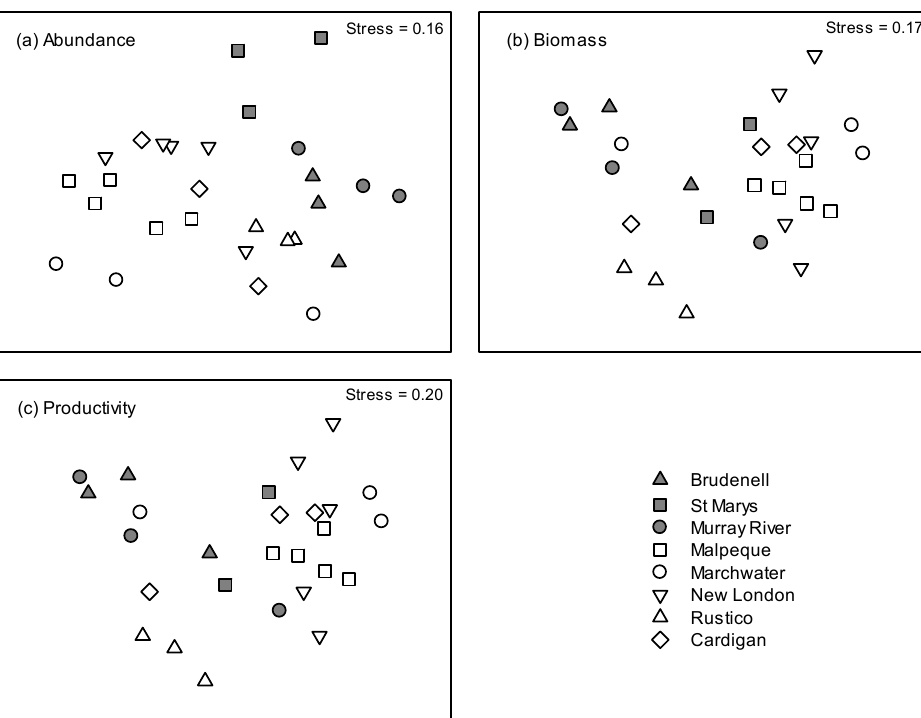
Figure 6. nMDS plots of ( a ) abundance, ( b ) biomass, and ( c ) productivity of mussel sock macroin- vertebrate assemblages in 8 bays on PEI. All data were √ -transformed prior to analysis. Filled sym- bols indicate bays infested by Styela clava , open symbols indicate bays without S. clava . Table 5. Results of SIMPER analysis of √ -transformed mussel sock macroinvertebrate abundance, indicating taxa contributing most to total dissimilarity between assemblages in bays with and with- out Styela clava .